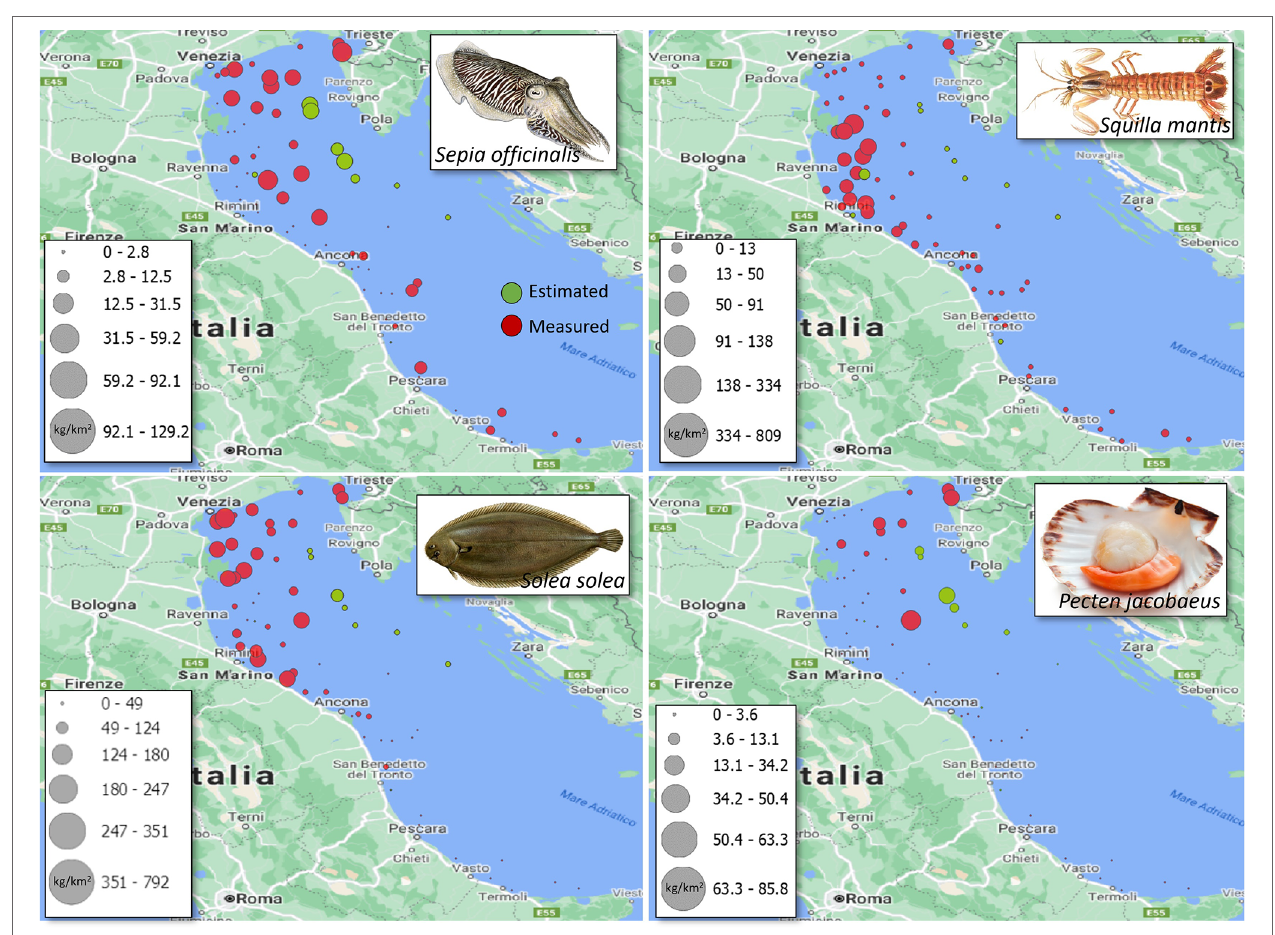
FIGURE 5 | Distribution of measured (red) and estimated (green) SoleMon biomass-indexes per haul for